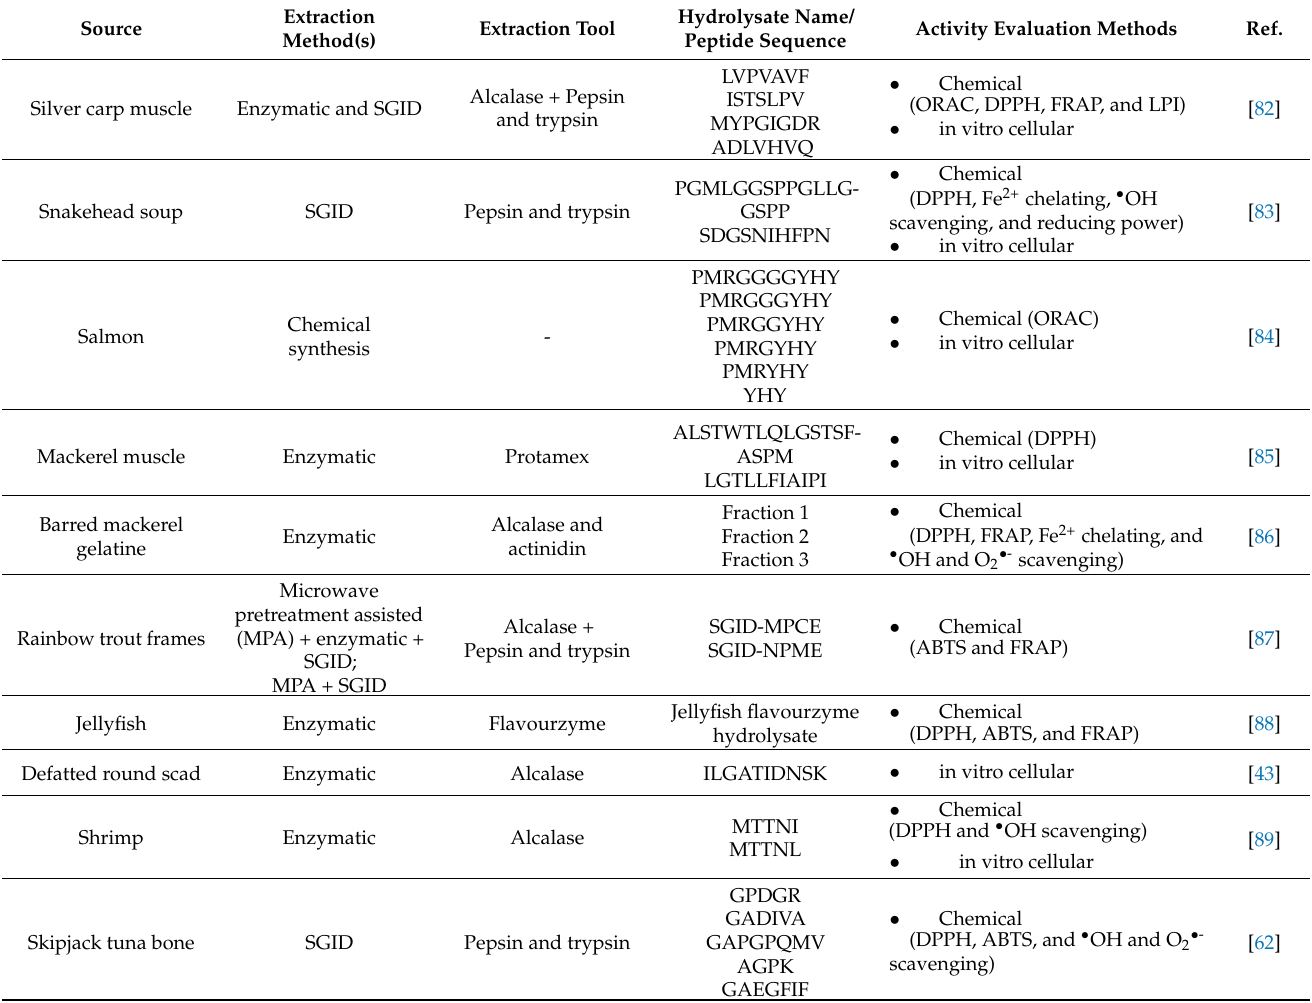
Table 1. Marine and diary sources of antioxidative hydrolysates and